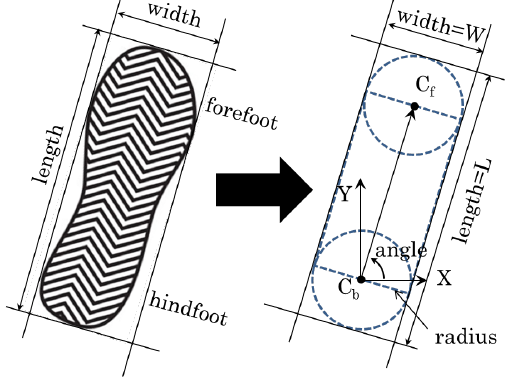
Fig. 5. Foot Model